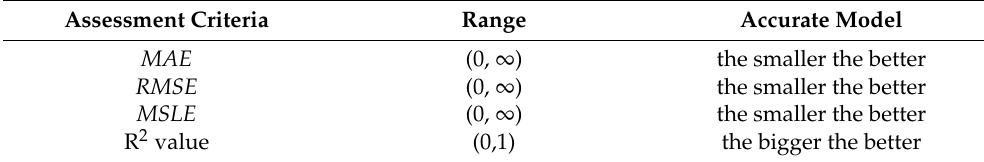
Table 4. Range of errors for statistical parameters.